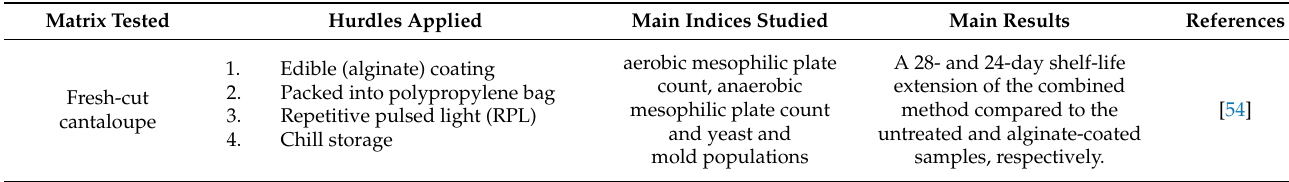
Table 1. Indicative studies on the application of hurdle technology on fresh-cut fruits and vegetables (Abbreviations: RPL: repetitive pulsed light; OD: osmotic dehydration; HHP: high hydrostatic pressure; SAEW: slightly acidic electrolyzed water; US: ultrasound; MH: mild heat treatment; AA: ascorbic acid; HR: 4-hexylresorcinol; CM: chamomile; MAP: modified atmosphere packaging; PP: polypropylene; GO: garlic oil; AIT: allyl isothiocyanate; TVC: total viable count; PME: